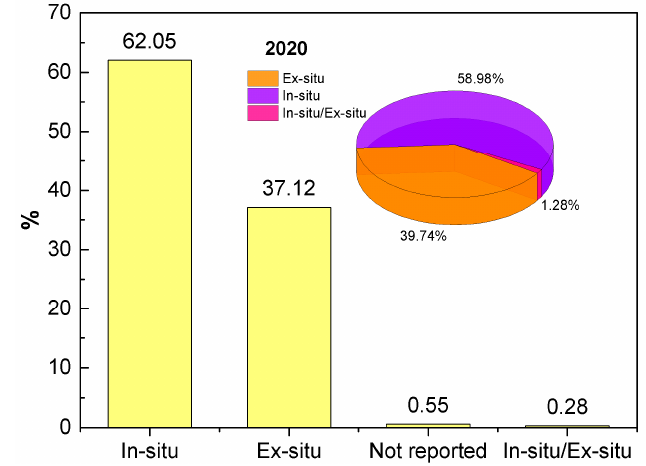
Figure 13. Incorporation of ZnO on nanocomposites.